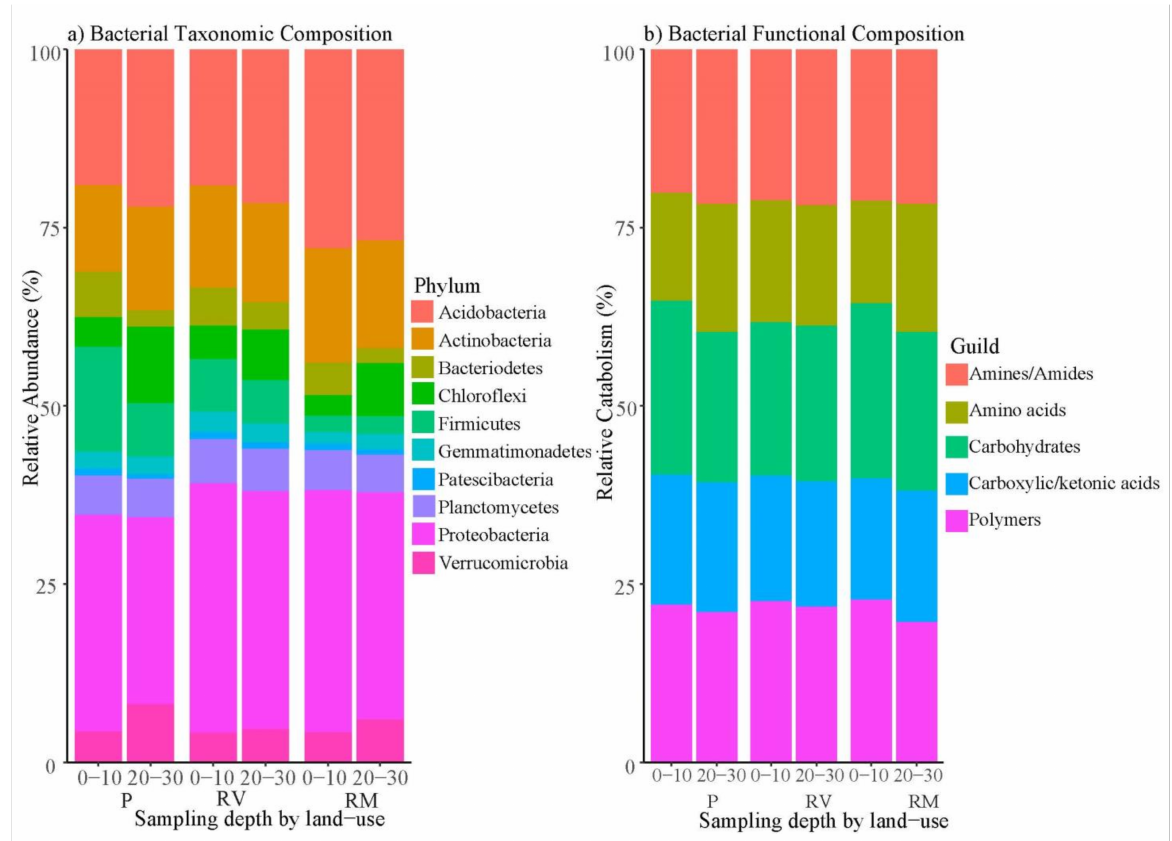
Figure 5. Relative abundance of bacterial community showing ( a ) bacterial taxonomic composition by phylum and ( b ) bacterial functional composition (CLPP—represented as AWCD) by carbon guild for each by land-use type; pasture (P), revegetated (RV), and remnant (RF), indicating proportions of each phylum or guild by land use across both depths (0–10 cm = surface soil and 20–30 cm =